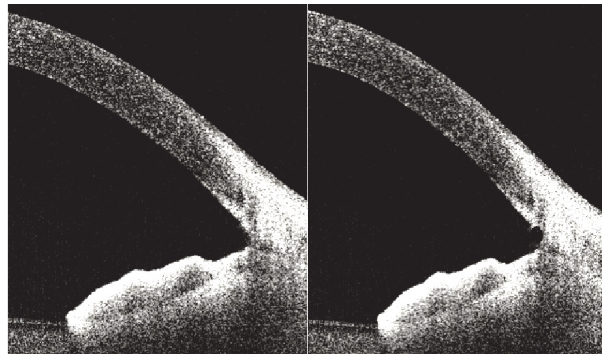
Figure 4: A cross-sectional OCT image of the nasal angle following Trabectome-onlysurgery.Thisframe-averagedimageshowsthatthe posterior trabecular meshwork has been